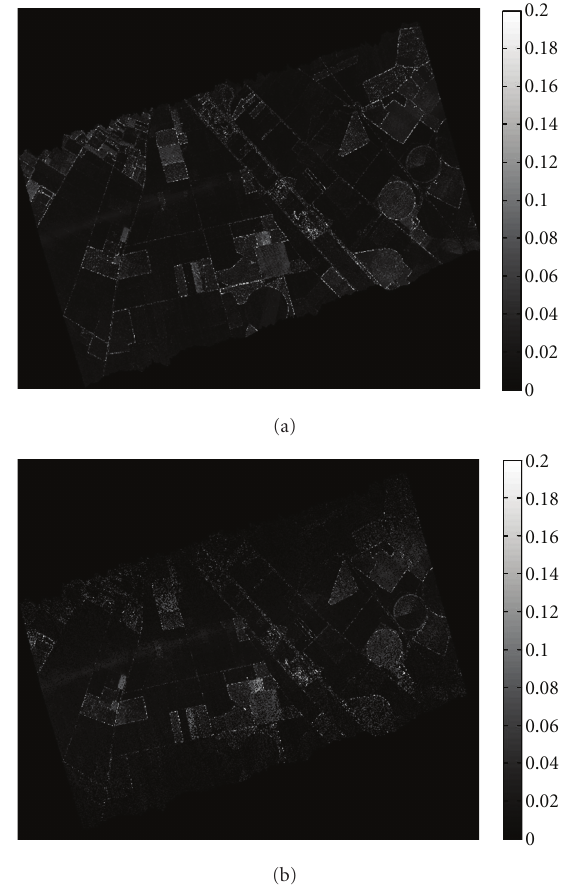
Figure 5: Visualization of the change detection results. The range (0rad–0.2rad) has been considered as colour limits for a better representation. (a) Results for the geocorrected version of the data- set. (b) Results for the DMF version of the